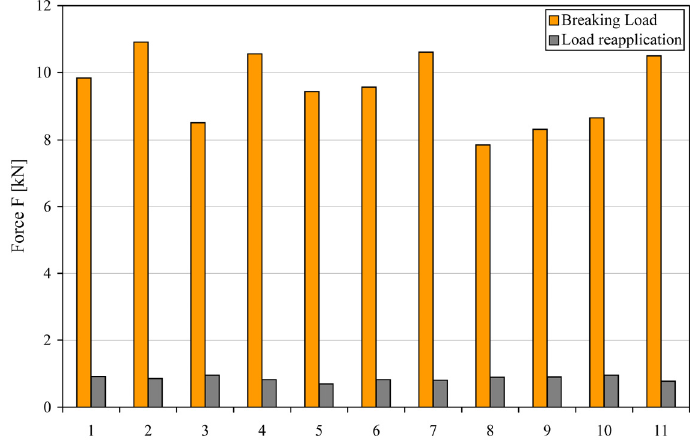
Figure 1: Breaking load and load reapplication of laminated glass beams.